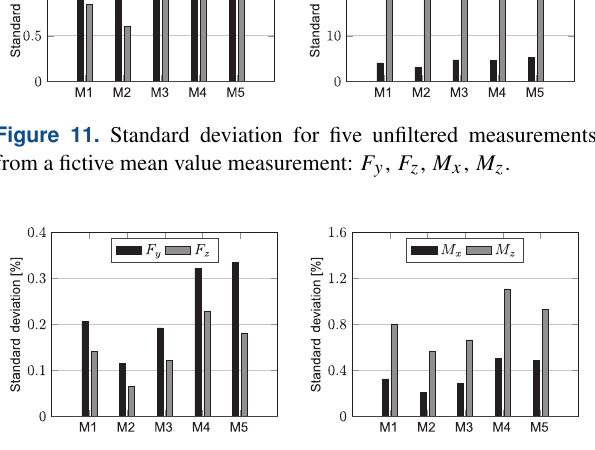
Figure 12. Standard deviation for five filtered measurements from a fictive mean value measurement: F y , F z , M x , M z , moving average filter with 200ms